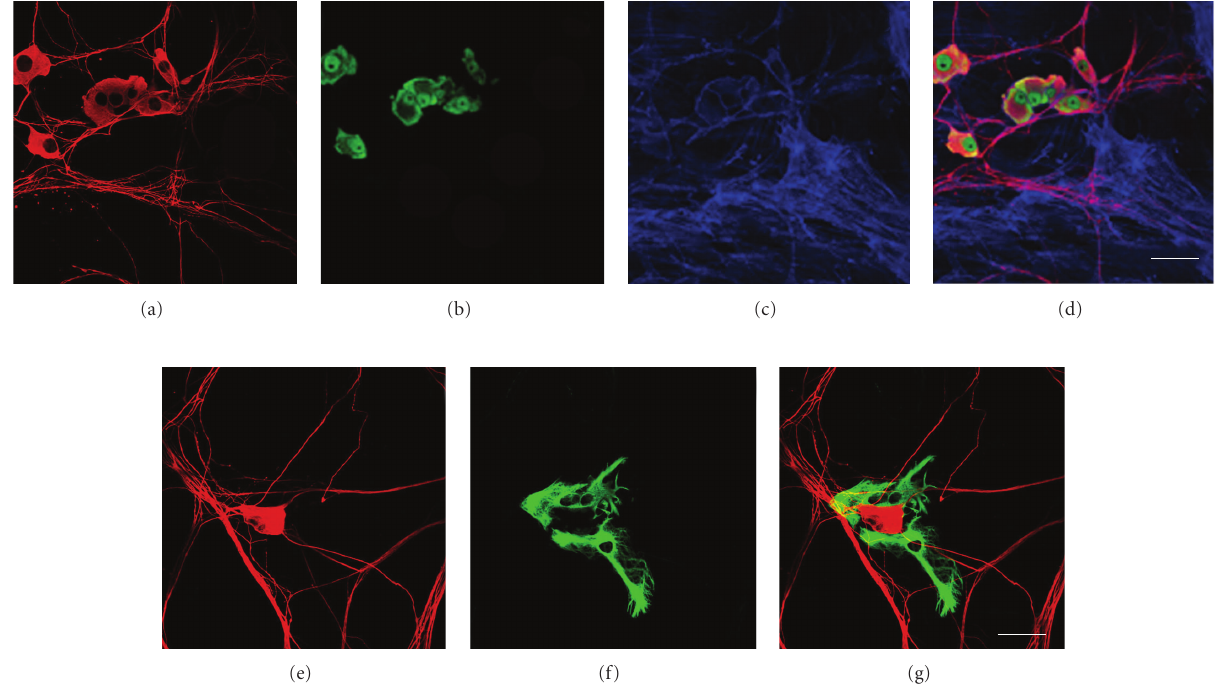
Figure 4: Control cultures represented by DRG primary cultures, in which neurons and glial cells were present. Phalloidin-staining labeled actin filaments in blue (c). Only neurons were positive for β III tubulin (a and e, red) and Neun (b, green), and only glial cells were GFAP positive (f, green). Merges (d and g). Bars: 50 μ